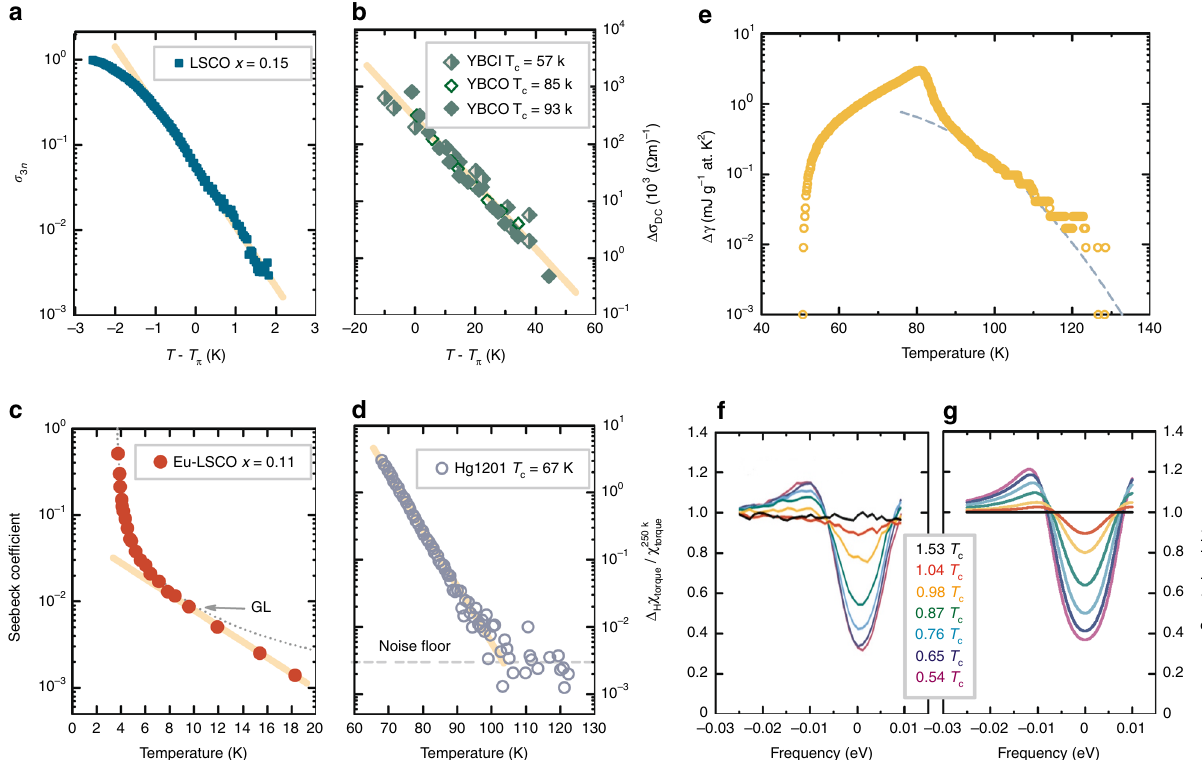
Fig. 4 Universal percolation physics in the cuprates. a – d Four different experimental probes show qualitatively similar non-GL behavior (full lines) above T c : a nonlinear conductivity of optimally doped LSCO (this work); b superconducting contribution to DC conductivity of YBCO, adapted from ref. 7 ; c Seebeck coef fi cient of europium co-doped LSCO ( x = 0.11) adapted from ref. 8 — the dotted line is the 2D GL prediction valid within 2 K of T c ; d torque magnetometry in underdoped Hg1201 ( T c = 67 K) — the dashed line indicates the noise fl oor. Adapted with permission from Yu et al. 15 . The decay constants of different observables are proportional to the universal scale Ξ 0 , but with different prefactors that can be directly calculated from the suggested model (see Methods). e Speci fi c heat coef fi cient. The orange circles are measured values of the superconducting contribution to the speci fi c heat coef fi cient, Δ γ , for Y 0.8 Ca 0.2 Ba 2 Cu 3 O 6.75 (from ref. 29 ), and the dashed line is a calculation that convolutes a mean- fi eld step in γ at the local T c with a Gaussian distribution of T c . The line is obtained with a distribution width of 35 K, similar to the value of Ξ 0 ; it is similar to the dashed line in Fig. 2a, since in a mean- fi eld picture the speci fi c heat essentially measures the superconducting fraction above T c . The measurements also show a fl uctuation peak around T c , which is not included in the calculation. f Measured tomographic density of states for optimally doped Bi 2 Sr 2 CaCu 2 O 8 + x reproduced from ref. permission from APS. g Calculated density of states, assuming a Gaussian gap distribution with full width of 3.2 meV (see Methods). In a – d the lines